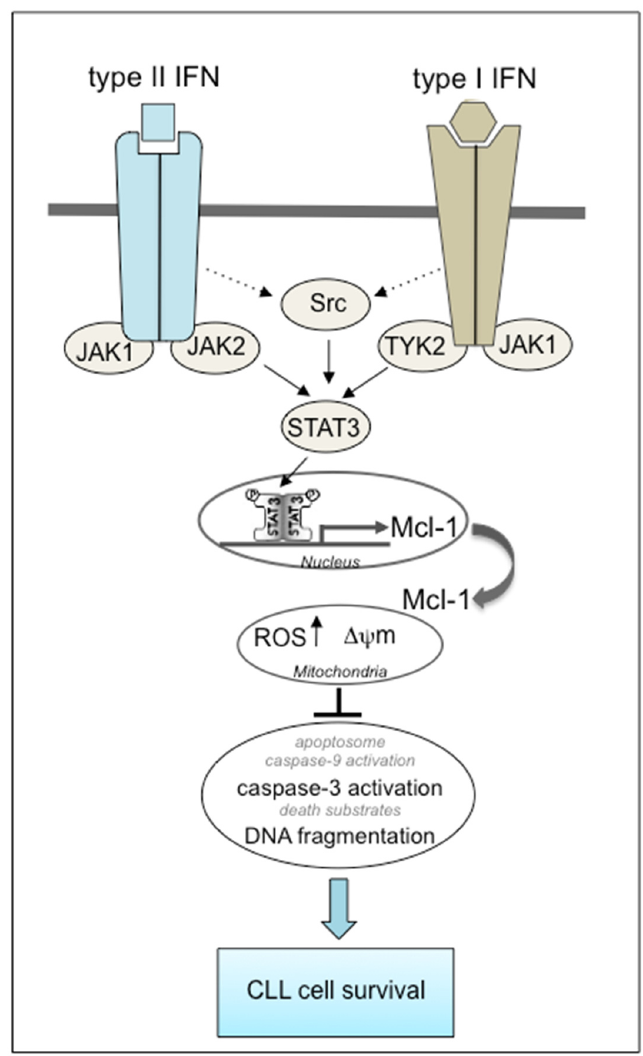
Figure 4. Putative model for the involvement of cell signaling pathways in the induction of survival by type I ( α / β ) and II ( γ ) IFNS in CLL cells. By binding to their respective IFN-receptors, type I and II IFNs likely lead to the activation of JAKs (TYK2 and JAK2 respectively) and an Src member ki- nase, which in turn activate STAT3. STAT3 dimer enters the nucleus and binds the MCL1 promoter. Following MCL1 transcription, Mcl-1 protein accumulates in the cytoplasm, and Mcl-1 exerts its anti-apoptotic activity by preventing mitochondrial depolarization, leading to the inhibition of caspase-3 activation and DNA fragmentation, ultimately favoring cell resistance to apoptosis. Both type I and II IFNs increase ROS mitochondrial concentrations, possibly through the sequential ac- tivation of STAT3 and its target gene LPL that shifts the metabolic program of CLL cells towards the utilization of lipids and then to an abundant ROS production into the mitochondria; increase,